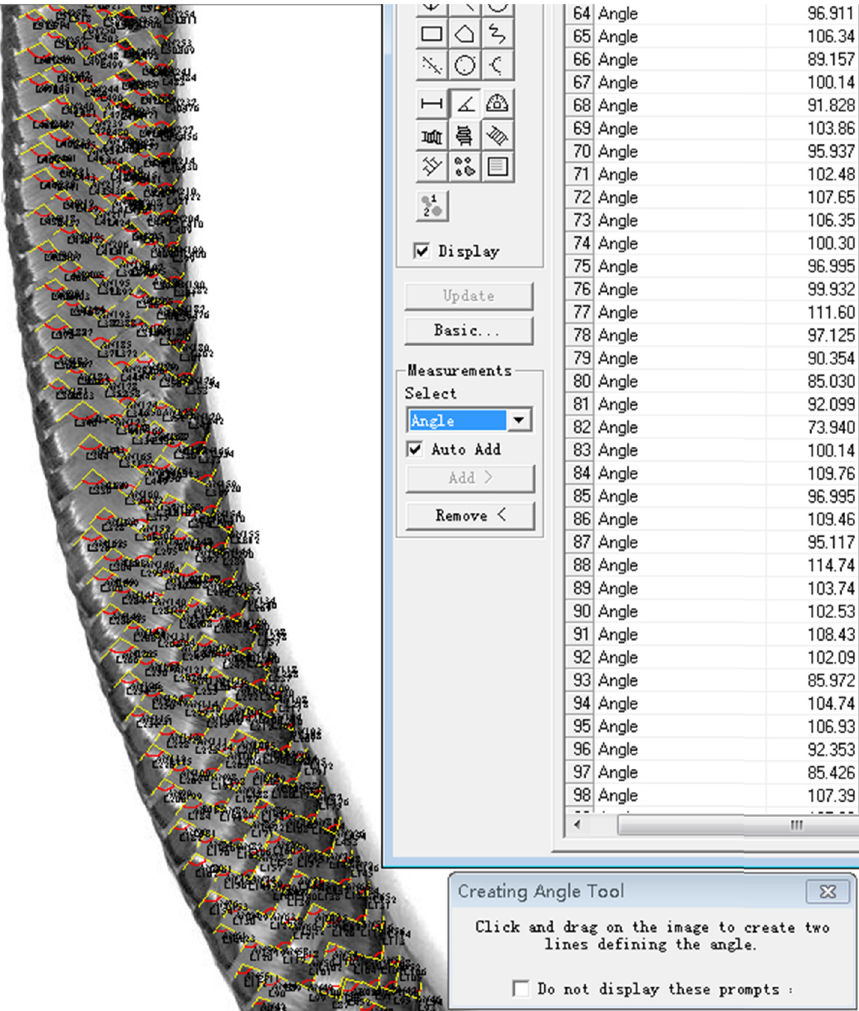
Figure 6: Measurement of braiding angles.